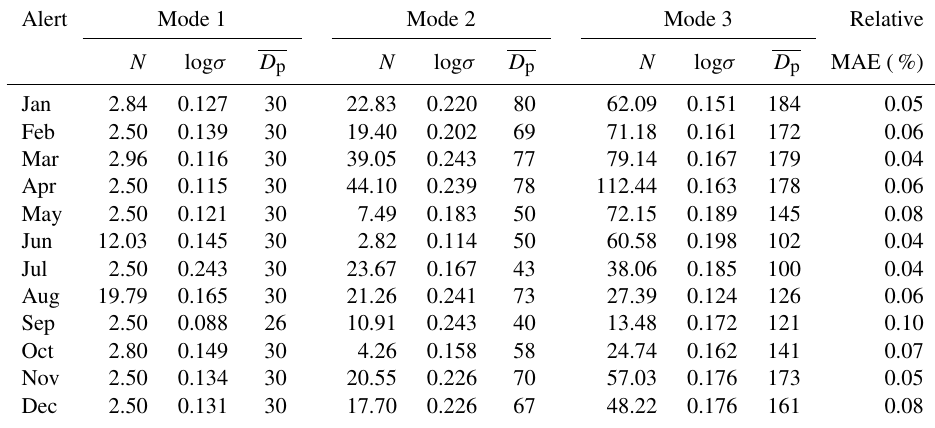
Table A1. The fitting parameters of the monthly median aerosol number distribution for Alert along with the relative mean absolute error. The units of N and D p are cm − 3 and nm, respectively. The geometric standard deviation is unitless and the normalized mean absolute error is given on percents.